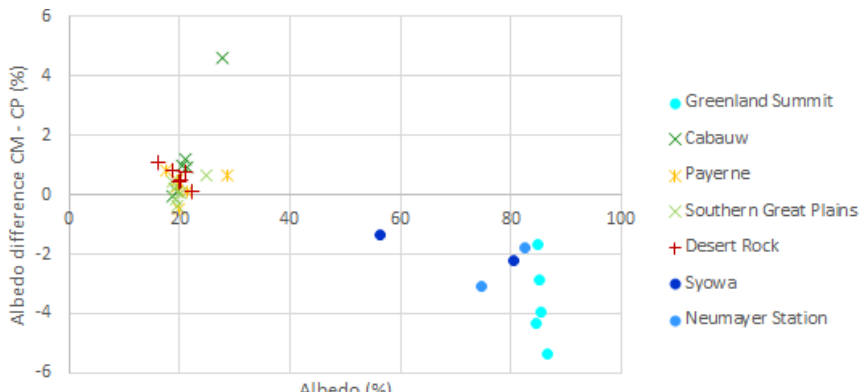
Figure 7. The difference between the monthly mean surface albedo estimates derived using the cloud masking (CM) and cloud probability (CP) approaches for several Northern Hemisphere test sites in July 1979, April 1981, November 2008, April 2009, July 2018 and April 2020. For Greenland Summit, no satellite albedo data were available for November 2008 due to low solar elevation. For the Southern Hemisphere sites Syowa and Neumayer Station, data were available for January 1979 and November